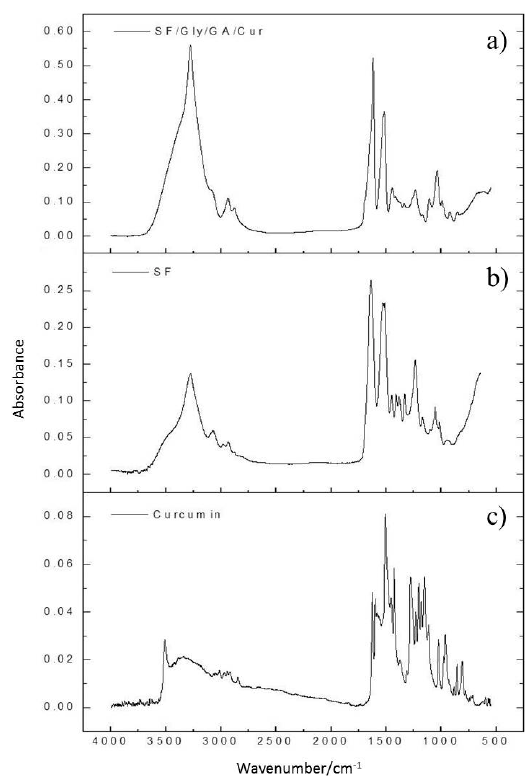
Figure 6. FTIR spectra of the SF / Gly / GA / Cur composite film ( a ), the SF film ( b ), and the pure curcumin ( c ).